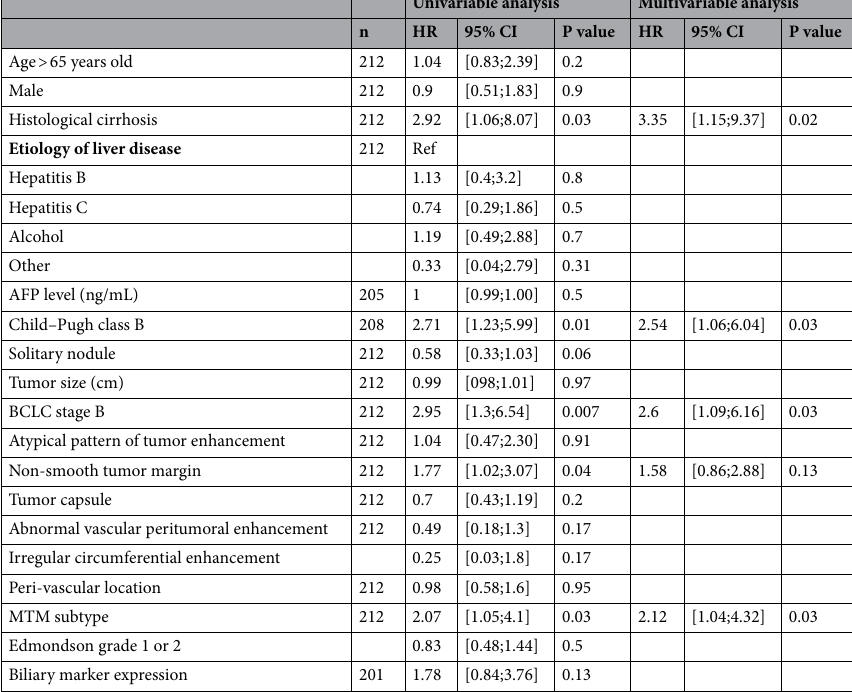
Table 3. Univariable and multivariable analysis of baseline characteristics associated with overall survival. AFP, alphafoetoprotein level; BCLC, Barcelona Clinic Liver Classification; HR, hazard ratio; MTM, macrotrabecular massive.